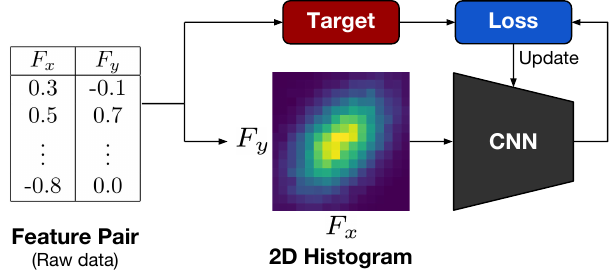
Figure 2. The implementation of dependence representation